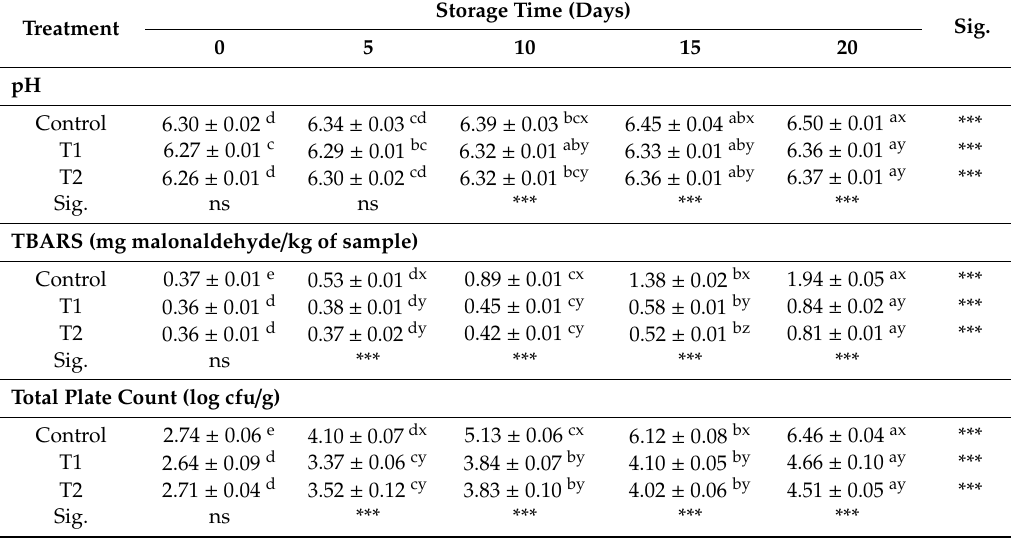
Table 4. E ff ect of Moringa flower on pH, thiobarbituric acid reactive substances (TBARS) and microbial count (log cfu / g) of chicken nuggets during the storage time (mean values ± error standard of six